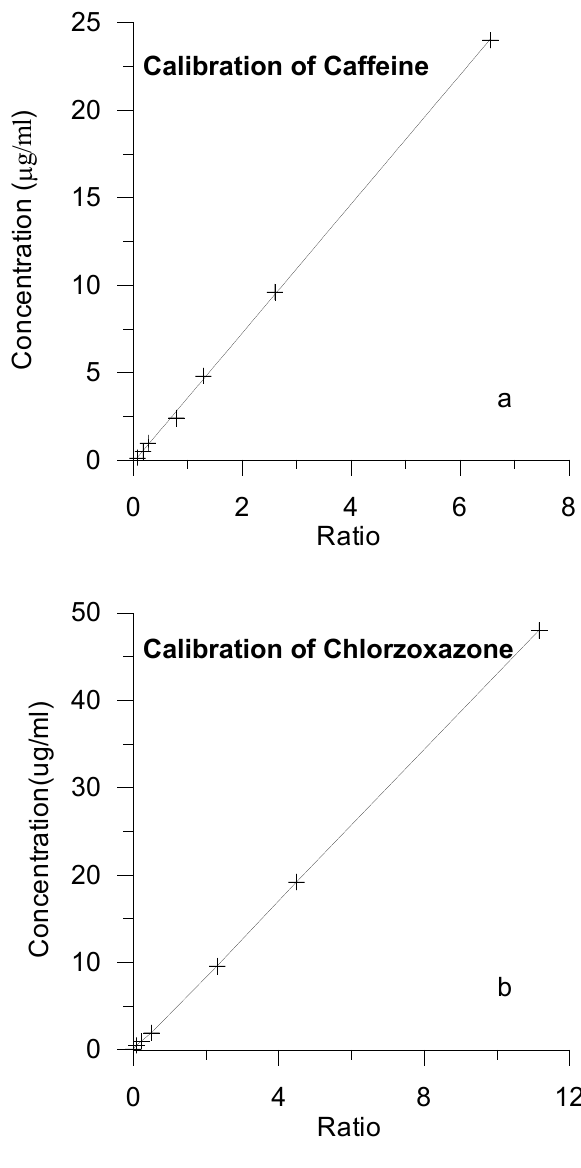
Figure 3. Calibration Curves for a) Caffeine b) Chlorzoxazone